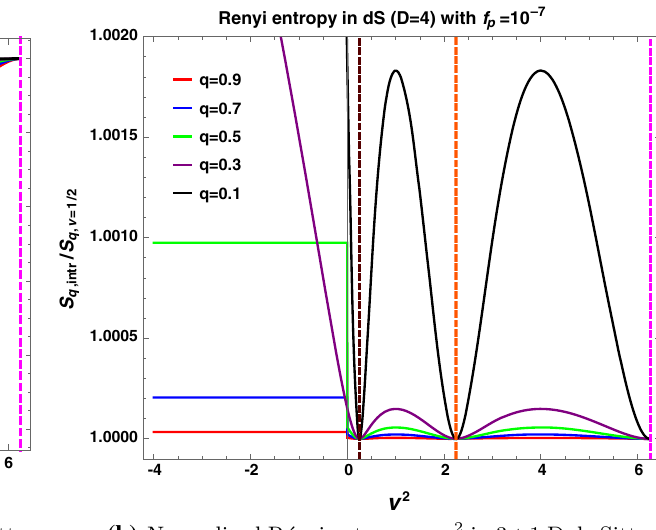
( a ) Normalized R´ e nyi entropy vs ν 2 in 3+1 D de Sitter space without axionic source ( f p = 0). Fig. 8 Normalised Rényi entropy S intr / S ν = 1 / 2 vs. mass parameter ν 2 in 3 + 1 D de Sitter space in the absence of the axionic source ( f p = 0) and in the presence of axionic source ( f p = 10 − 7 ) for q = 0 . 1 ( black ), q = 0 . 3 ( purple ), q = 0 . 5 ( green ), q = 0 . 7 ( blue ), q = 0 . 9 ( red ) with